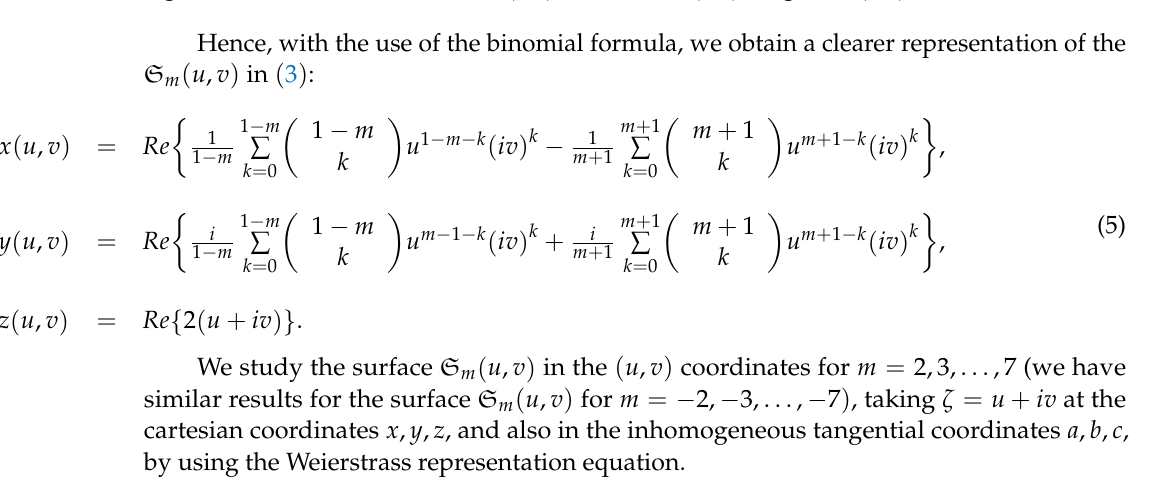
Figure 1. Minimal surfaces ( Left ) S 2 ( r , θ ) , ( Middle ) S 3 ( r , θ ) , ( Right ) S 4 ( r , θ )